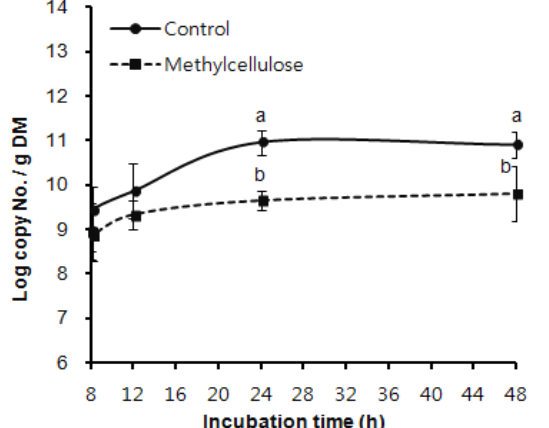
Figure 1. Detachment of Fibrobacter succinogenes on rice straw as influenced by MC addition after 8 h of incubation. a,b Means with different letters differ significantly (p<0.05).